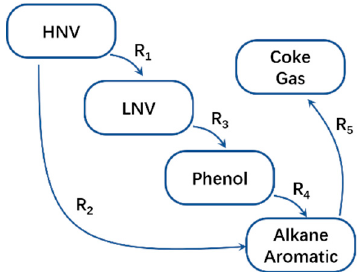
Figure 1. Design and schematics of the integrated hydrogen production and pyrolytic oil upgrading process. ( a ) Conventional process with a water–gas-shift (WGS) reactor and pressure swing adsorption (PSA) unit; ( b ) integrated steam methane reforming-hydrotreating process without a WGS reactor.